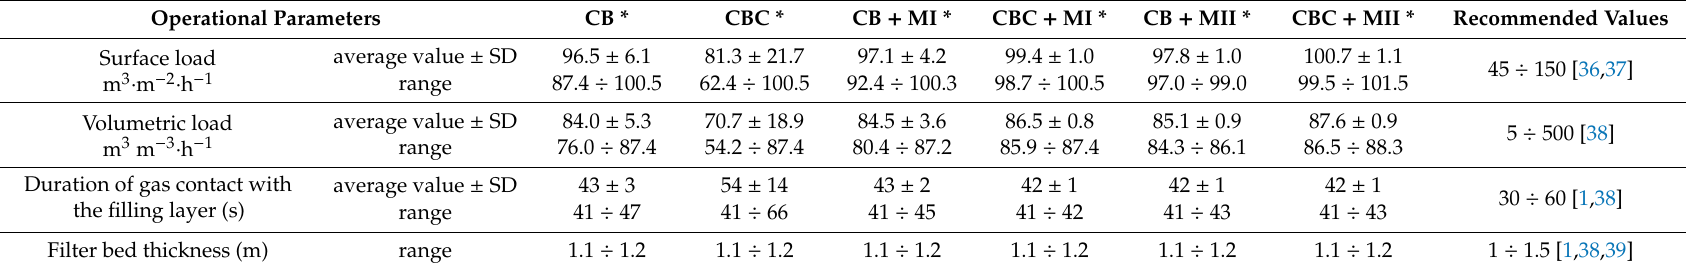
Table 2. Comparison of the basic operational parameters of the studied pilot biofilter.